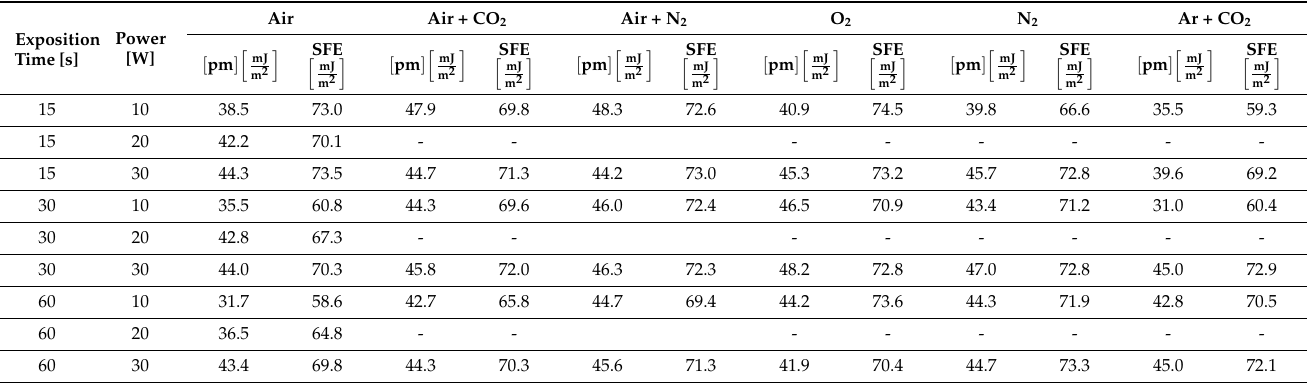
Table 2. Polar components [pm] and free surface energy SFE of the modified silicone